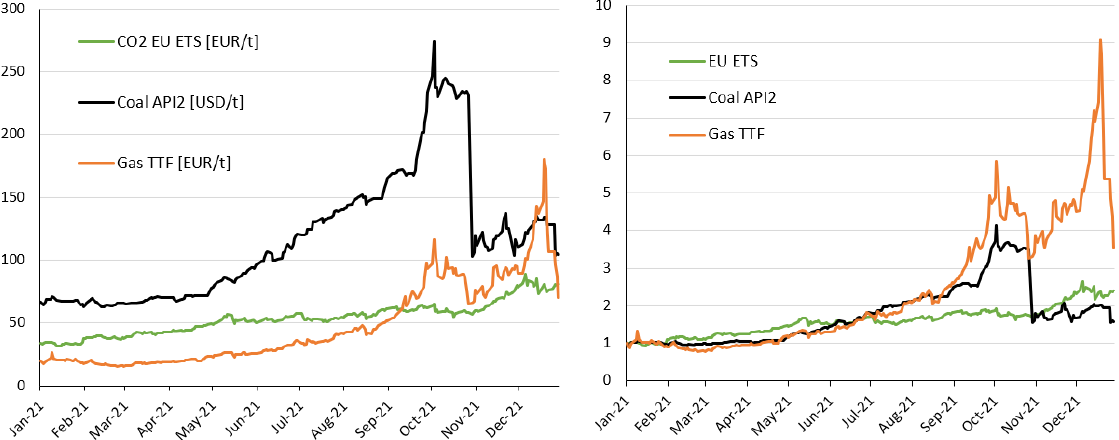
Figure 1. Development of commodity prices in Europe in absolute values ( left ) and indexed terms ( right ).